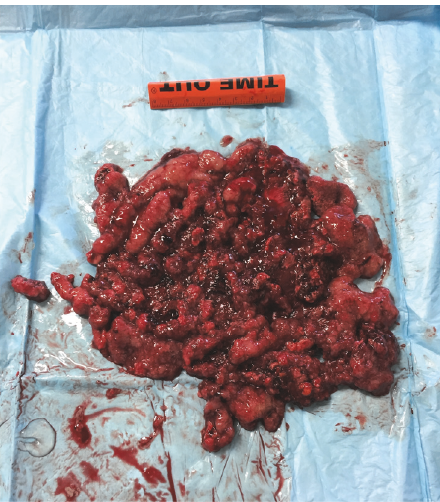
Figure 2: Macroscopic aspect of villous